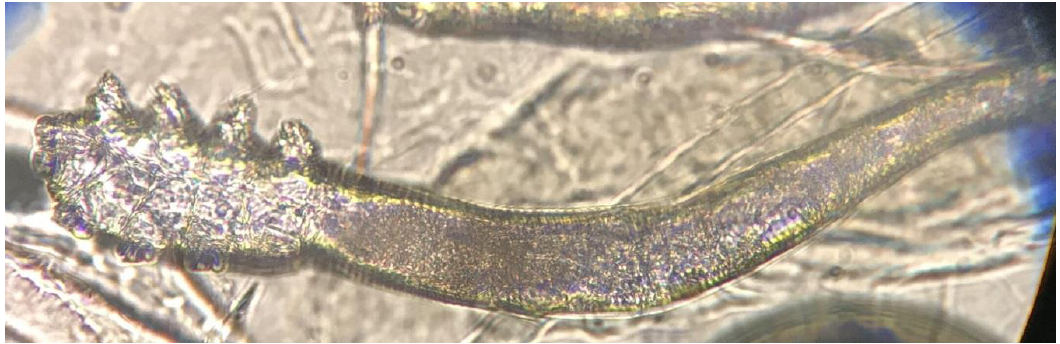
Figure 1. Single Demodex mite on standardized skin surface biopsies (SSSBs) under x40 magnification by light microscope.